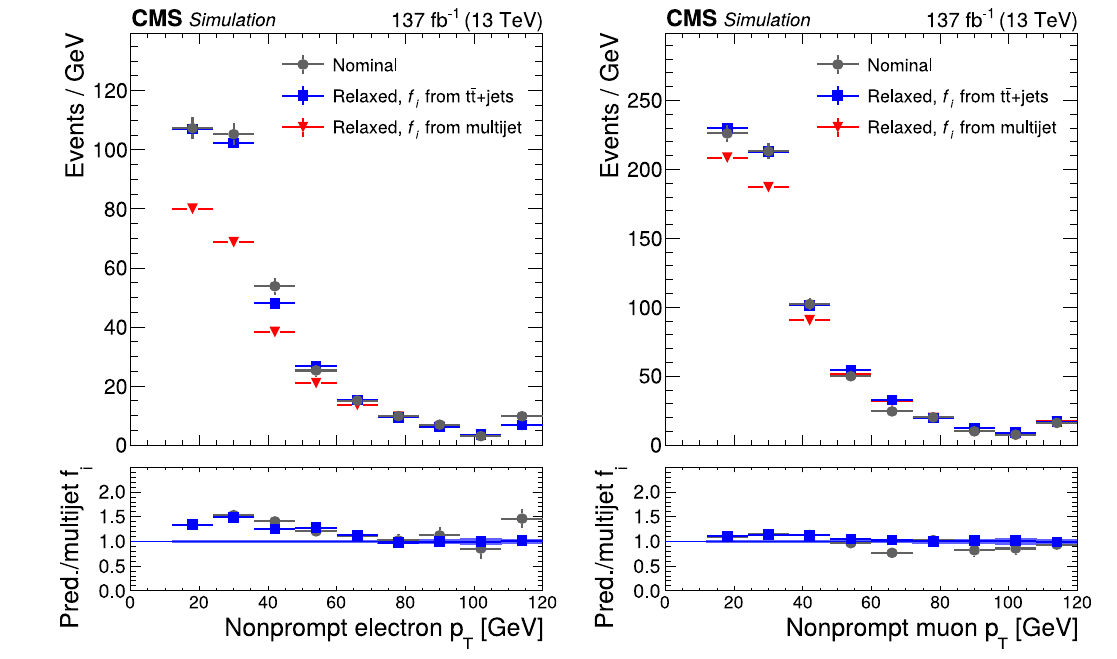
Fig. 6 Transverse momentum distributions of nonprompt (left) elec- trons and (right) muons in simulated tt+jets events, for the three cases “nominal”, “relaxed, f i from tt+jets”, and “relaxed, f i from multijet”